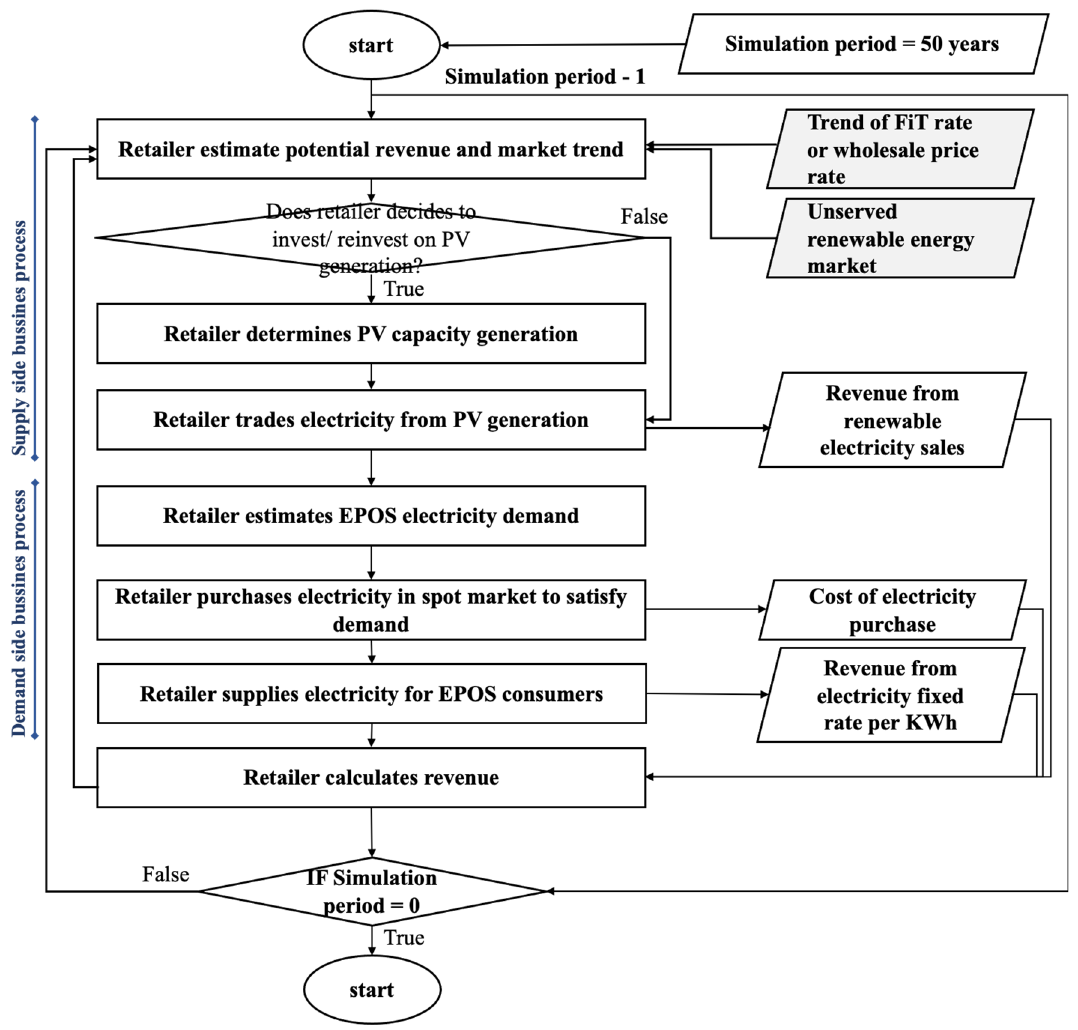
Figure A2. EPOS retailer behavior and decision flow. EPSS generation capacity focuses on satisfying demand from EPSS consumers. The decisional flow of EPSS retailers is described in Figure A3.